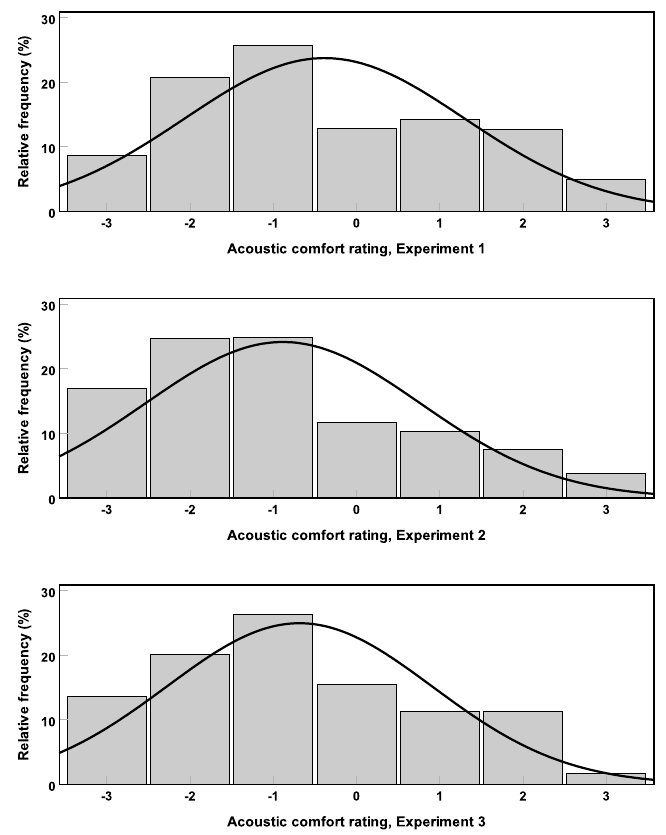
Figure 12. Acoustic comfort rating histograms for the data from Experiments 1 ( above ), 2 ( middle ) and 3 ( below ). Relative frequency is shown in